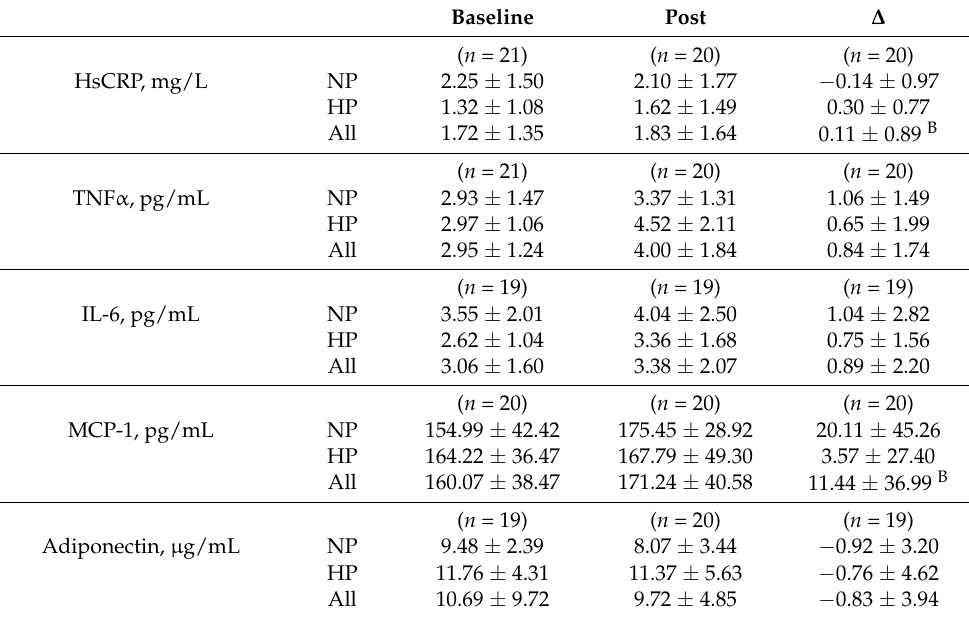
Table 6. Inflammatory status 1